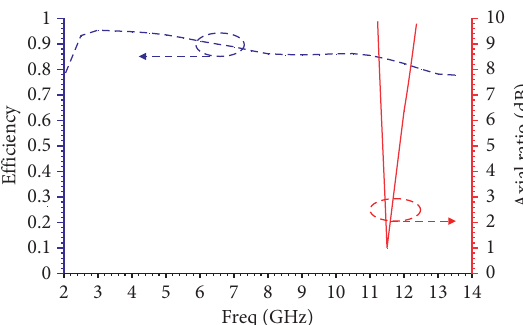
Figure 13: The simulated radiation efficiency and the axial ratio of the proposed